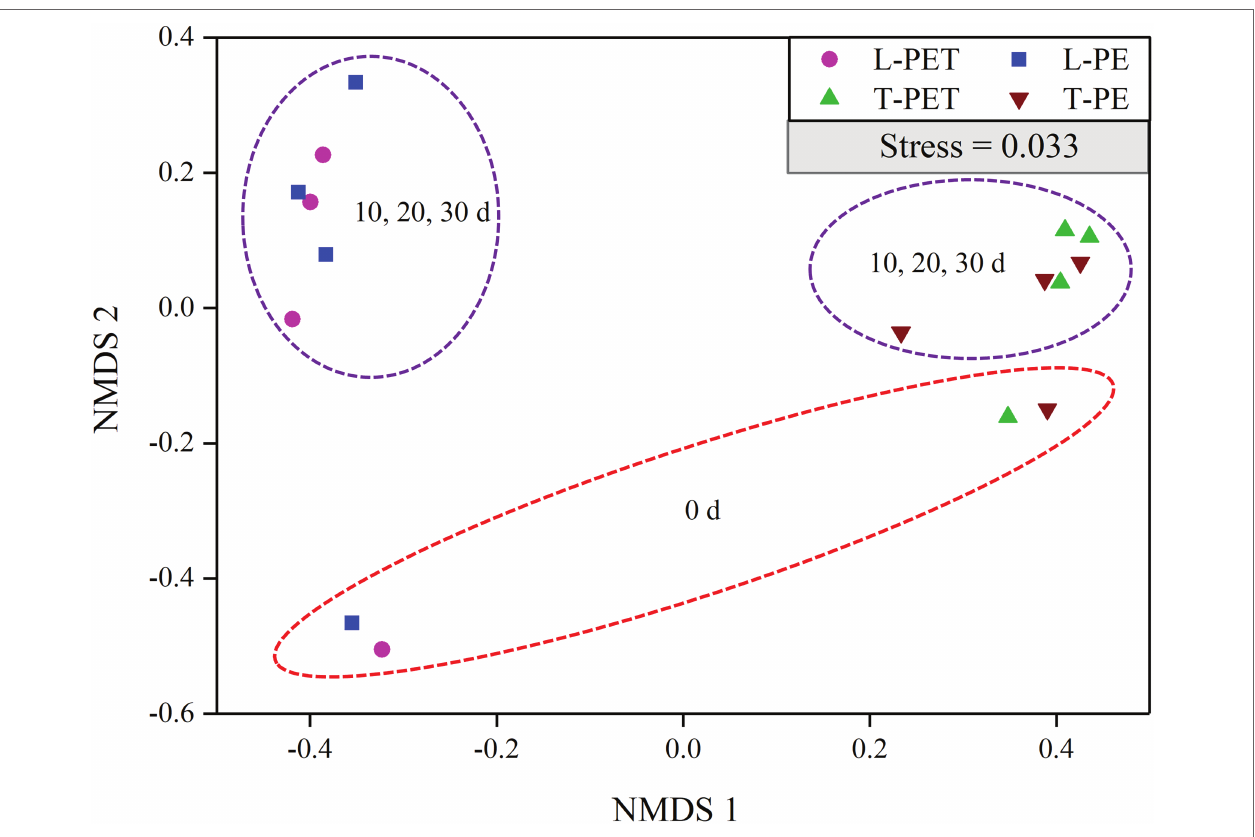
FIGURE 3 | Non-metric multidimensional scaling (NMDS) of biofilm bacterial communities originating from lake and tap water on microplastics (represented by OTUs) calculated with Bray–Curtis dissimilarity between samples. In this plot, points that are closer together represent more similar bacterial communities to each other than those further away. A low stress value indicates a robust